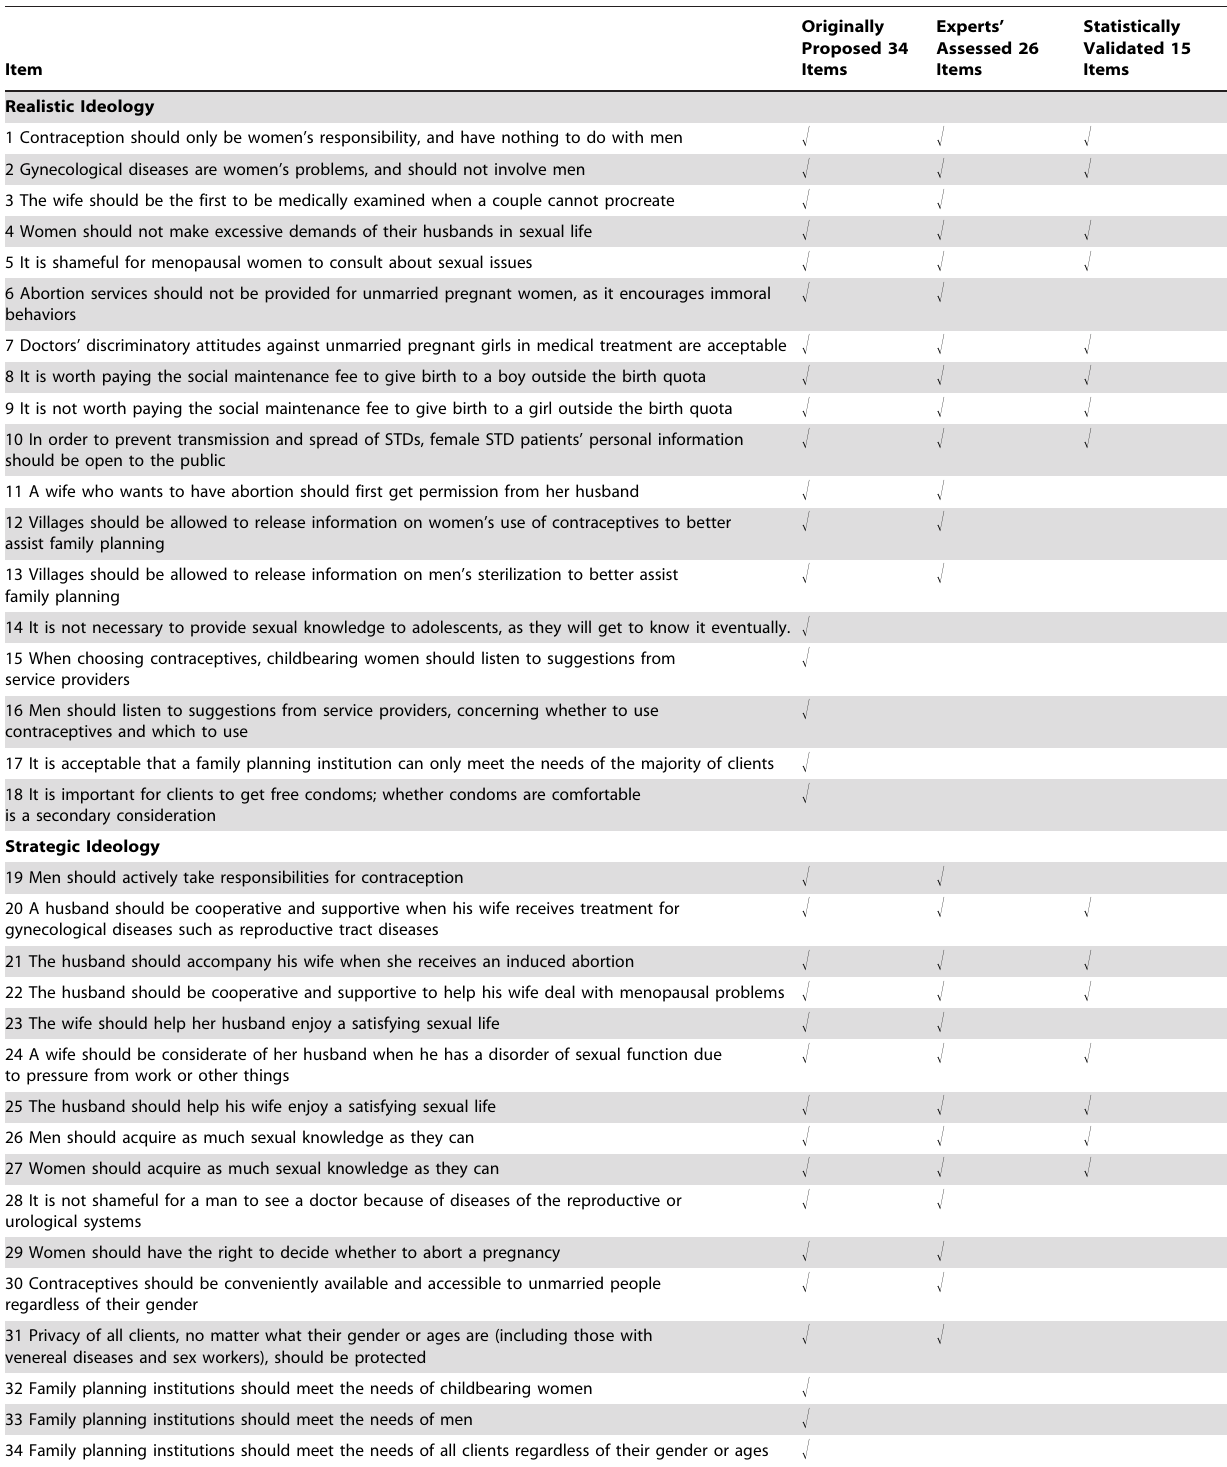
Table 2. Development of GIS-family